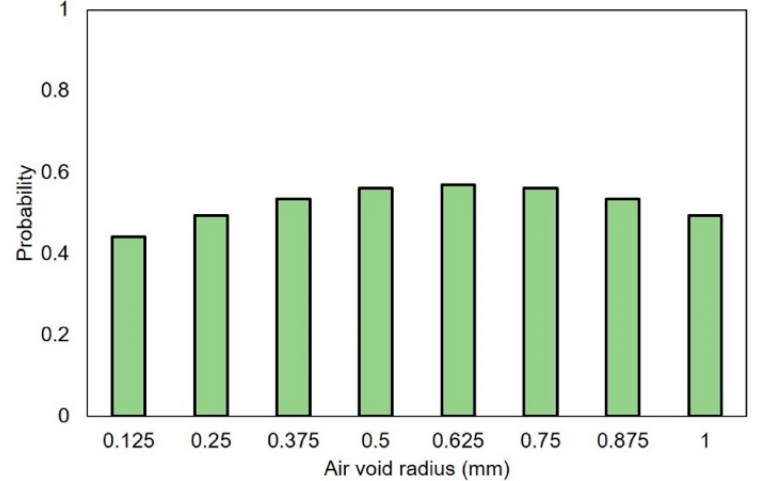
Figure 12. Distribution of air void radius.